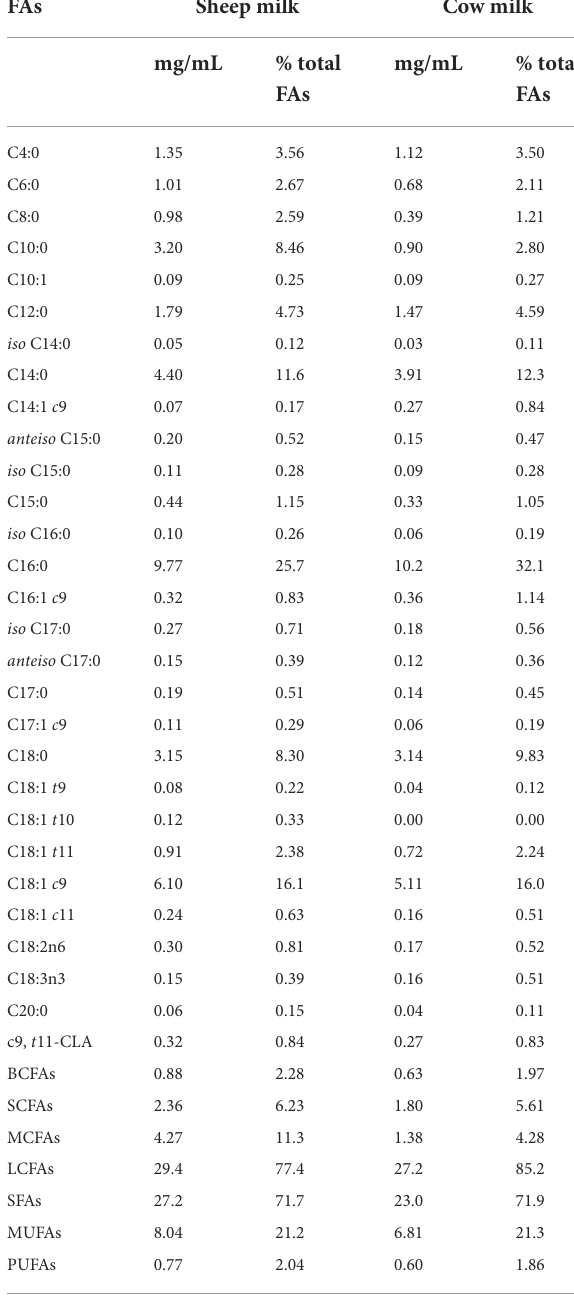
TABLE 2 Fatty acid composition of the sheep and cow milk test drinks * . FAs Sheep milk Cow